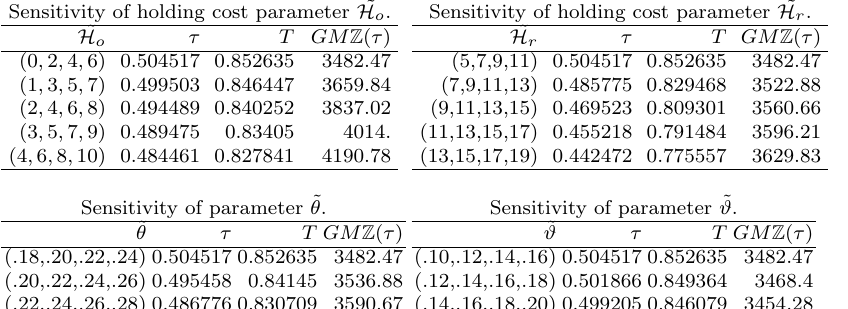
Table 2. Sensitivity of different cost parameters. Sensitivity of holding cost parameter ˜ H o